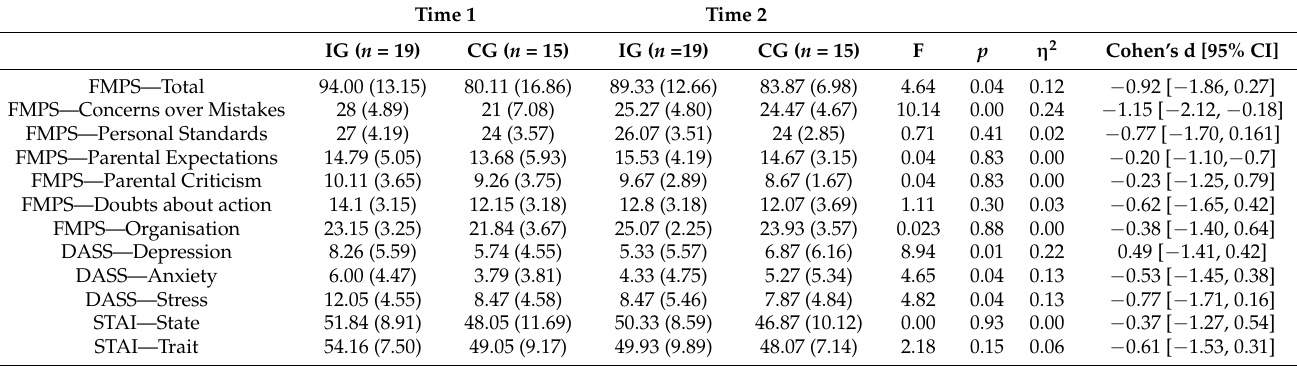
Table 3. Means, standard deviations, and two-way ANOVA statistics of group × time interactions. Time 1 Time 2 IG ( n = 19) CG ( n = 15) CG ( n = 15) p η 2 Cohen’s d [95% CI]